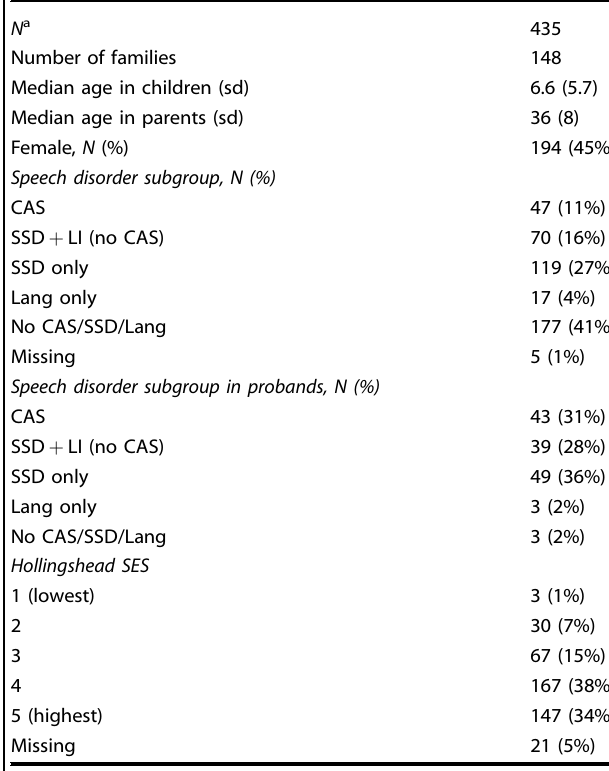
a Sample considered is the union of all samples across the 16 tests. Speci fi c test sample sizes and age ranges are shown in Supplementary Table 1.